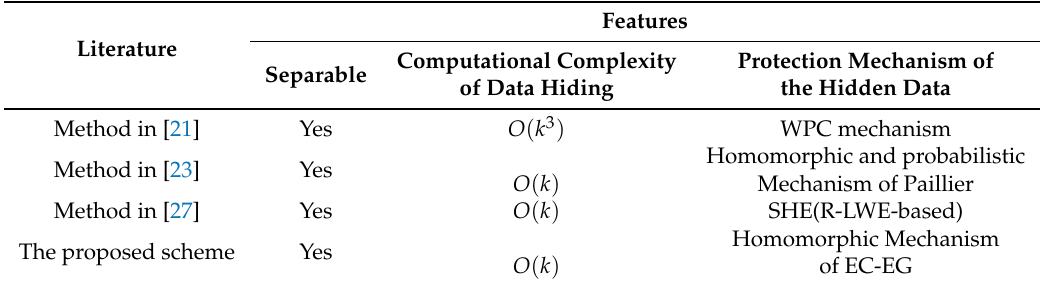
Table 4. Performance comparison of